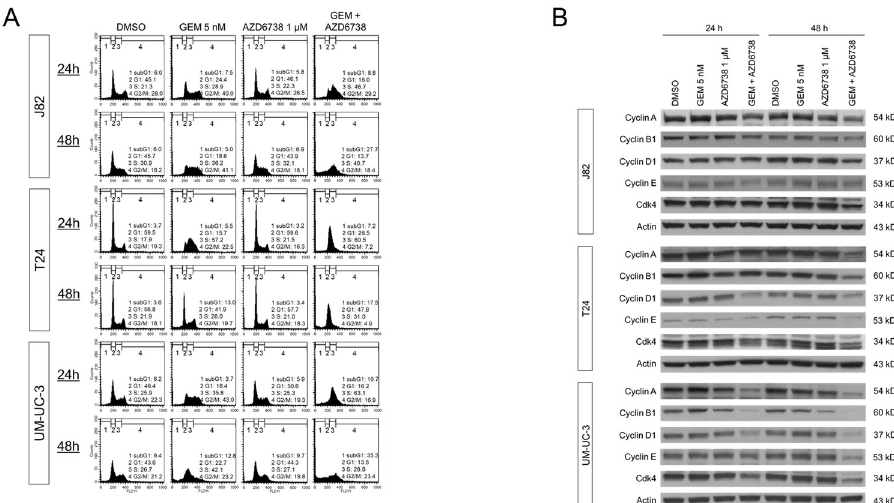
Fig 2. Effects of gemcitabine and AZD6738 on cell cycle distribution. (A) Flow cytometric cell cycle analyses following the indicated treatment for 48 h in three different bladder cancer cell lines. DMSO served as solvent control. (B) Cyclin A, cyclin B1, cyclin D1, cyclin E, and CDK4 protein expression levels after gemcitabine and/or AZD6738 treatment were determined by western blot analysis in comparison with DMSO control in the bladder cancer